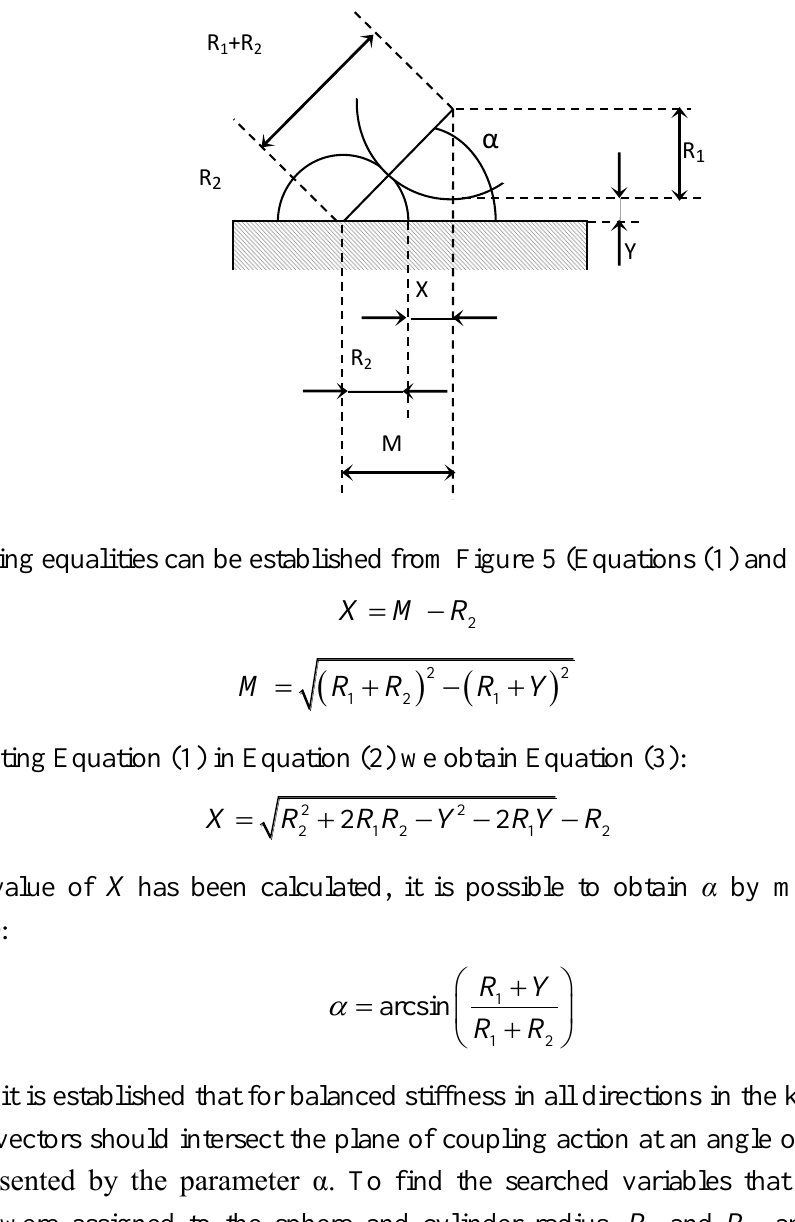
Figure 5. Kinematic coupling variables